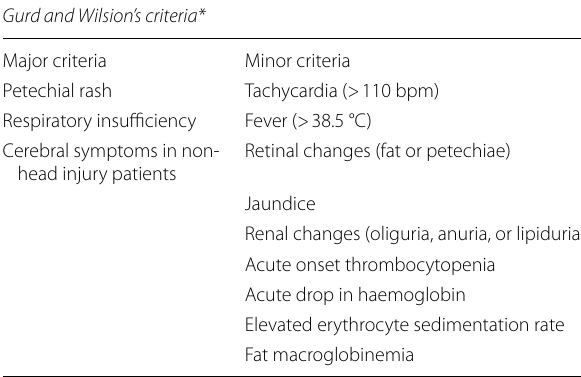
*The diagnosis of FES requires 2 major or 1 major and 4 minor criteria to be fulfilled